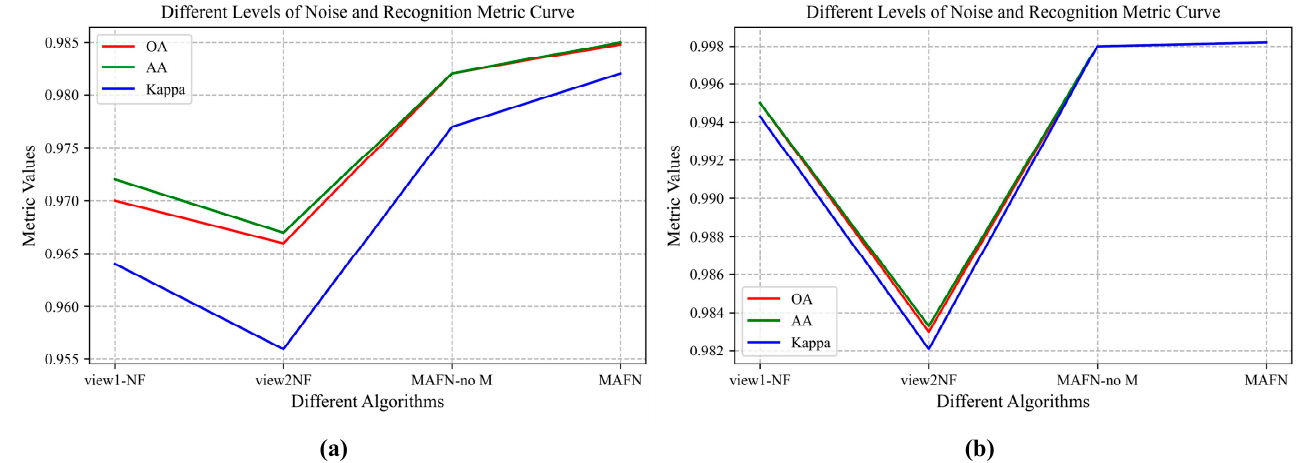
Figure 7. Analysis of the multi-scale module. ( a ) Results on dataset 1. ( b ) Results on dataset 2.